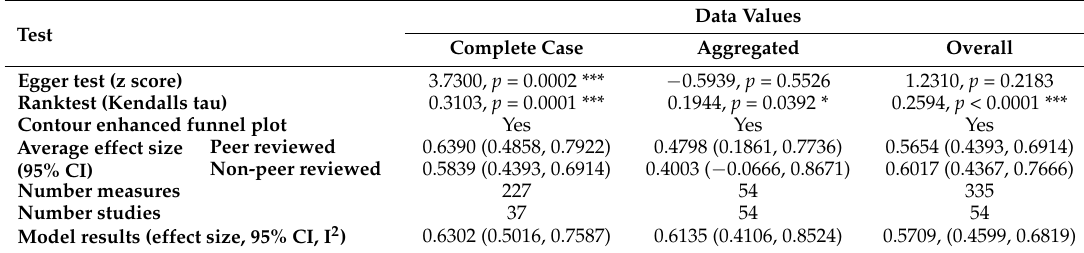
Table 2. Results from the Vevea and Hedges assessment of publication bias at the 0.05 cutpoint.